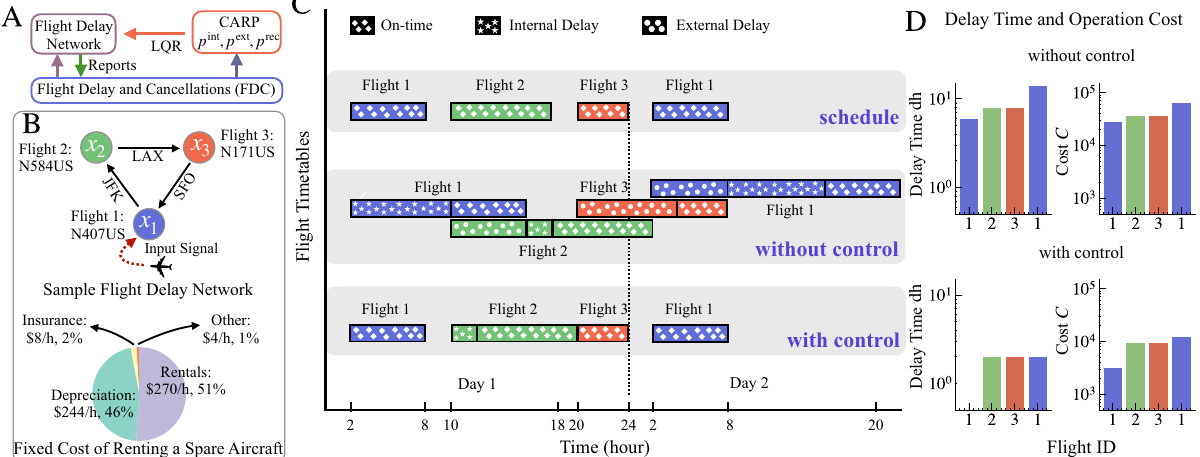
Figure 1. An illustration of the optimal control of a sample single aircraft flight delay network. ( A ) The flowchart of our framework for flight delay mitigation. The Flight Delays and Cancellations (FDC) data is the source for designing Flight Delay Network for each airline studied here. Using the CARP model, we formally define dynamics of the system, and its linearization and then apply the Linear Quadratic Regulator (LQR) to find optimal control. ( B ) A sample single aircraft flight delay network whose circular route includes three flights between three airports. Flight 1 N407US is selected as the driver node in controlling the flight delays. The pie shows the fixed cost of renting a spare twin-engine Boeing 737-401 to replace, if needed, the aircraft delayed in flight N407US from SFO to JFK airport. ( C ) The scheduled time of each individual flight, the actual flight time with and without control , under the assumption that some flights suffer delays. The details of these fights are discussed in the main text. ( D ) This part shows the delay time dh and cost C of each flight in the network produced by simulations with and without optimal